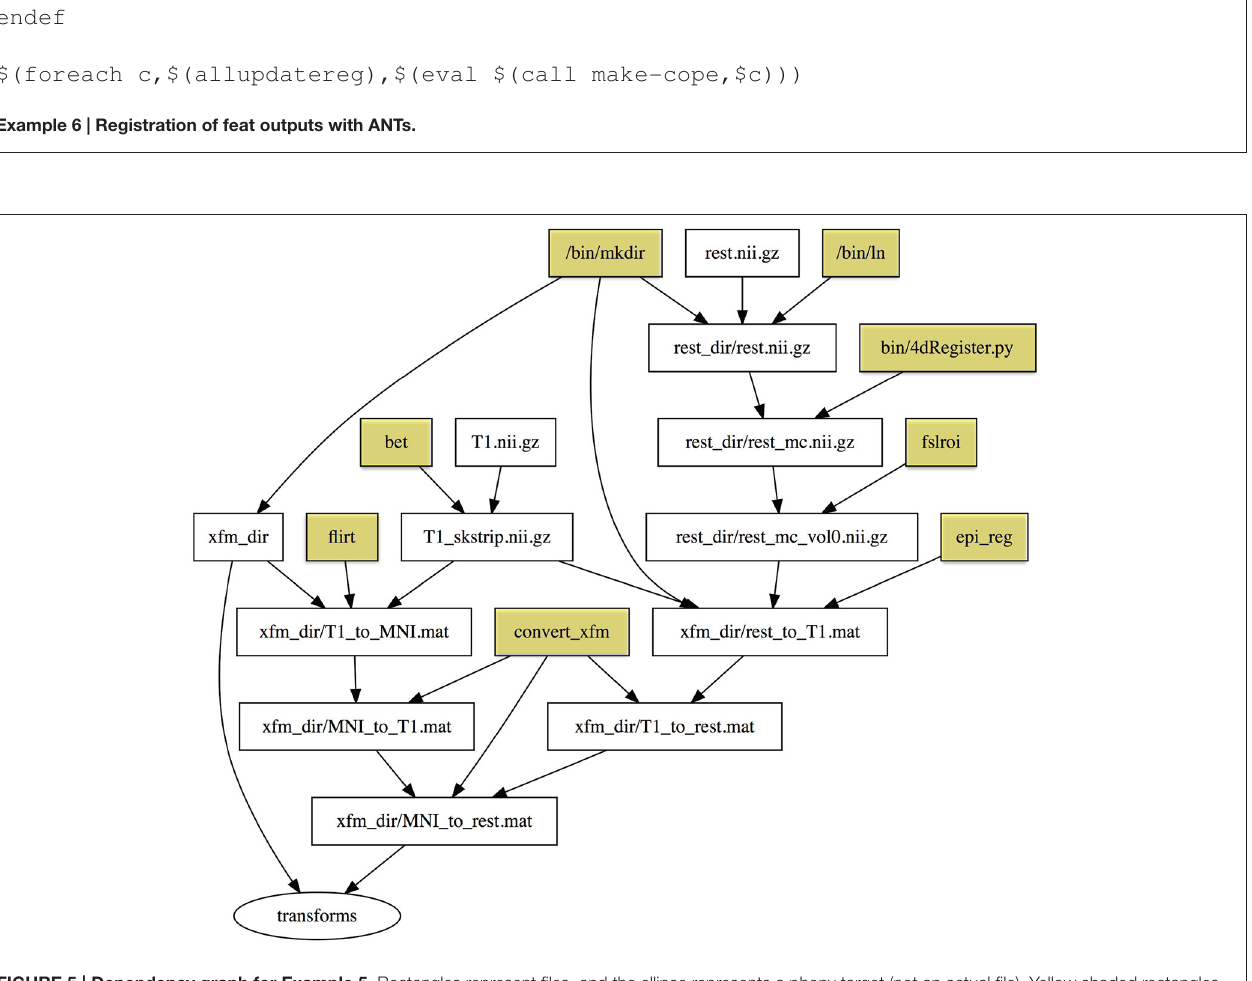
FIGURE 5 | Dependency graph for Example 5. Rectangles represent files, and the ellipse represents a phony target (not an actual file). Yellow shaded rectangles are programs installed on the system that are part of the default Linux distribution or FSL utilities, and are important for provenance but not dependency checking. To simplify the graph we do not include full paths to these programs as we did in Figure 2